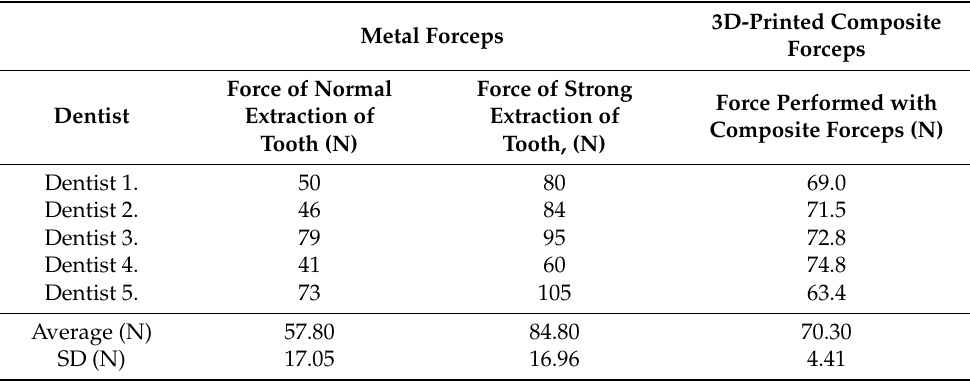
Table 2. Summary of the results of the simulation of tooth